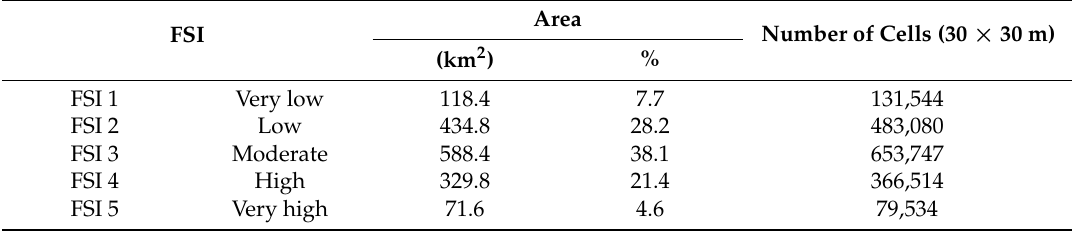
Table 8. Areas of the classes from the final flood susceptibility